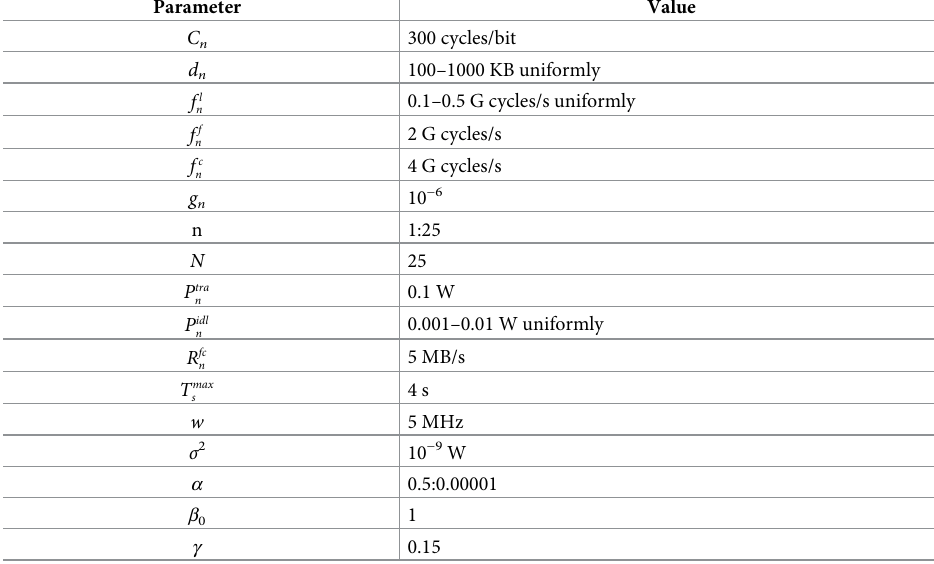
Table 2. Simulation